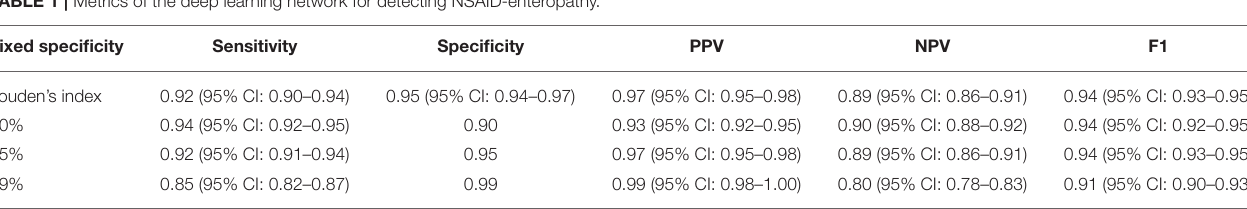
TABLE 1 | Metrics of the deep learning network for detecting NSAID-enteropathy. Fixed specificity Sensitivity